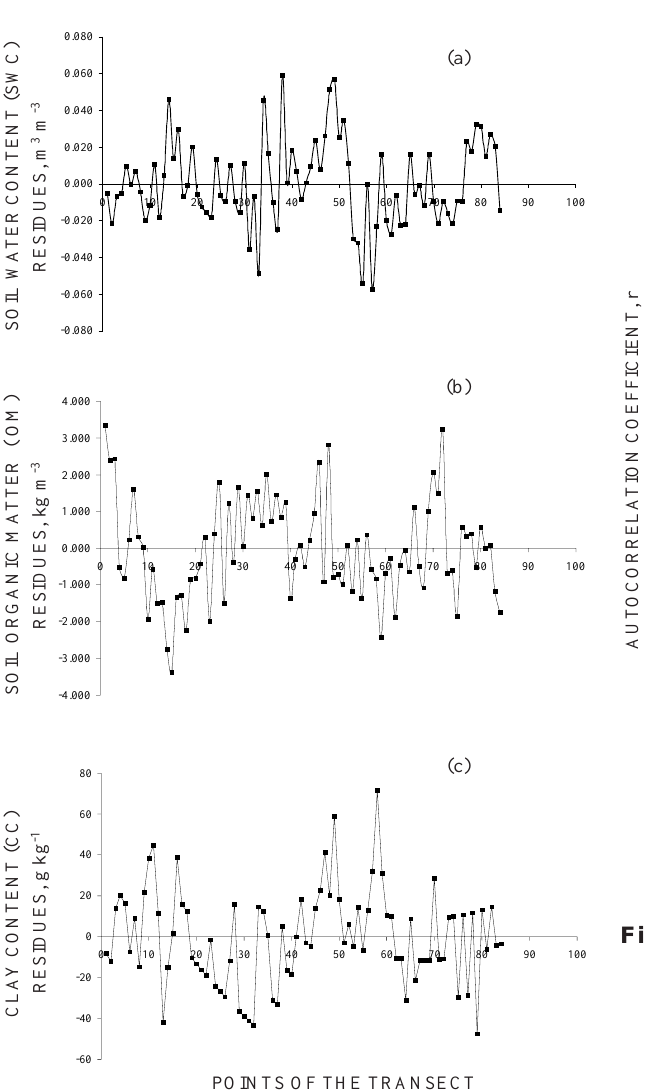
Figure 6. Soil water content residues distribution (a); soil organic matter residues distribution, (b); and clay content residues distribution, meter by meter, along the 84 point transect (c).